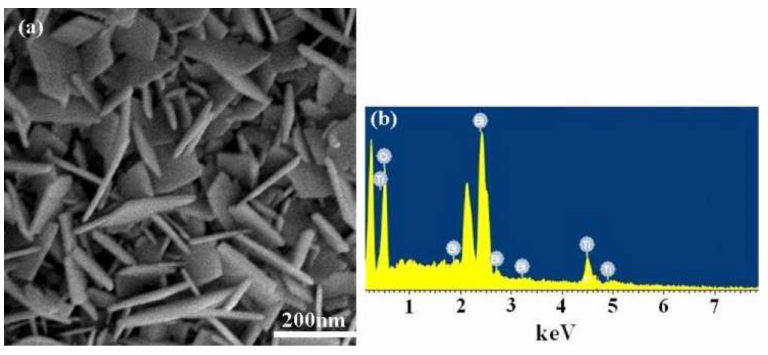
Figure 1. ( a ) SEM image; ( b ) energy dispersive spectroscopy (EDS) pattern of the pristine Bi 4 Ti 3 O 12 powders synthesized using a sol-gel hydrothermal technique at 160 ◦ C for 16 h.